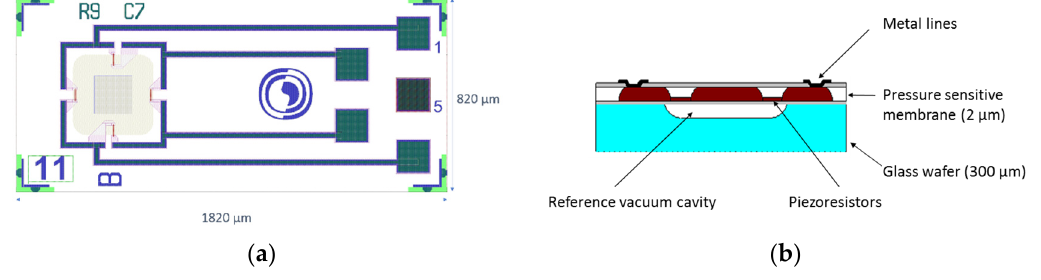
Figure 2. ( a ) A MEMS sensor element, top side view; ( b ) cross ‐ sectional view.